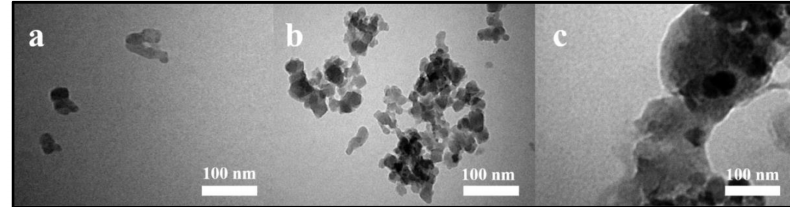
Figure 6. TEM image of ( a ) CdS, ( b ) Ag 3 PO 4 , and ( c ) Pt-Ag 3 PO 4 / CdS /